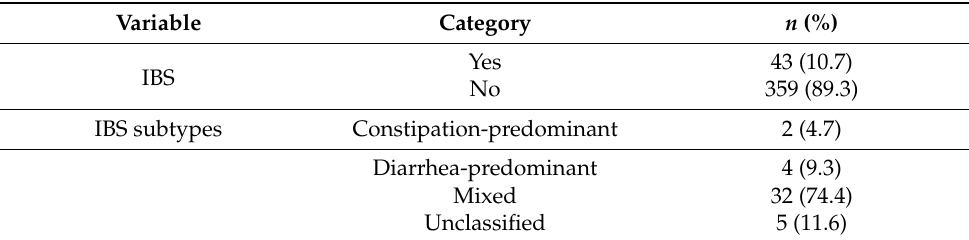
Table 3. Prevalence of IBS diagnosed by Rome IV and distributions of IBS subtypes ( n = 402).